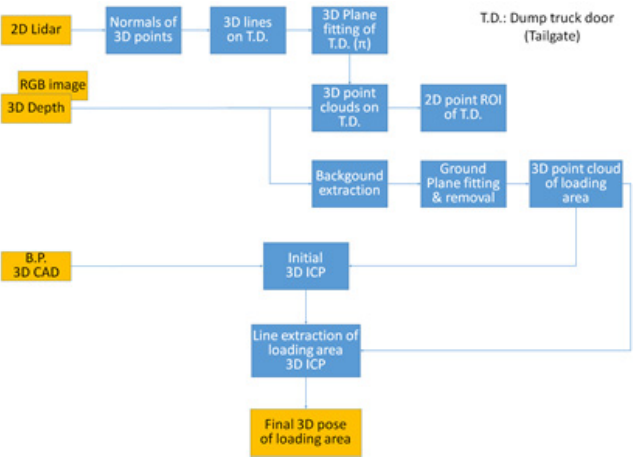
Figure 7. Flow chart of 3D pose localization processing of truck cargo box.